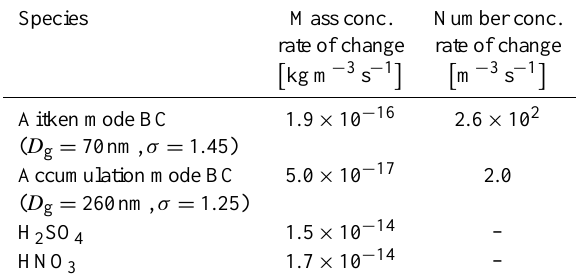
Table 4. Emission and formation rates used in the test case. Species Mass conc. Number conc.